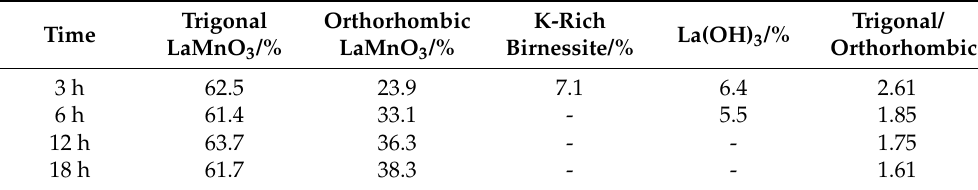
Figure 2. Rietveld phase quantitative analysis of the LaMnO 3 powder at 18 h. The experimental powder X-ray diffraction data (black + marks), calculated powder X-ray diffraction data (black solid line) and the difference between experimental and calculated data (black lower line) are shown. Tick marks the reflection positions for trigonal (red, upper) and orthorhombic (blue, lower) LaMnO 3 . Table 1. Phase compositions of the hydrothermal products at different stages.